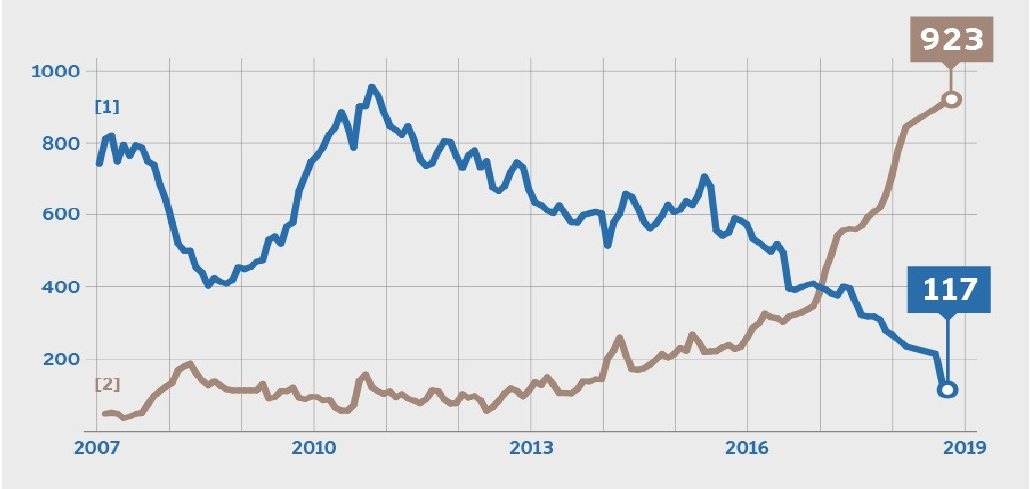
Figure 1. (1) Conscientious objectors imprisoned; and (2) pending cases of conscientious objectors 7 .